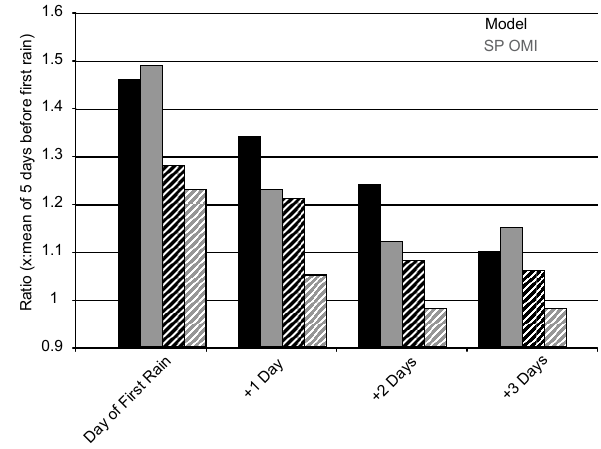
Fig. 8. Mean (solid) and median (diagonal lines) enhancements in the OMI Standard Product (grey) and GEOS-Chem (black) tropo- spheric NO 2 vertical column densities (VCDs) following the first rainfall of the wet season (April–June 2006) over the African Sa- hel grasslands (0–30 ◦ W, 10–18 ◦ N, boxed region in Fig. 7a) are shown. Ratios are taken against the average VCD in the 5 days preceding the first rainfall. All OMI VCD data are averaged daily to 0.25 ◦ × 0.25 ◦ latitude/longitude resolution where cloud radiance fraction <